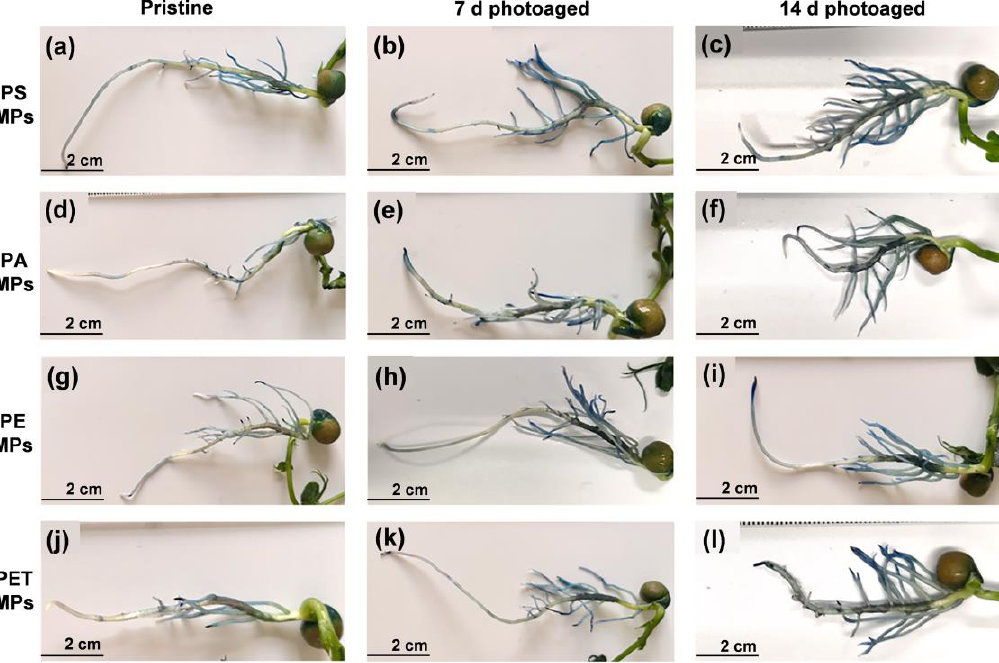
Figure 4. The growth status of seedling roots and Evans blue staining after 7 d of exposure to 100 mg L −1 particle suspensions of ( a – c ) PS, ( d – f ) PA, ( g – i ) PE, and ( j – l ) PET MPs photoaged for 0, 7, and 14 d.